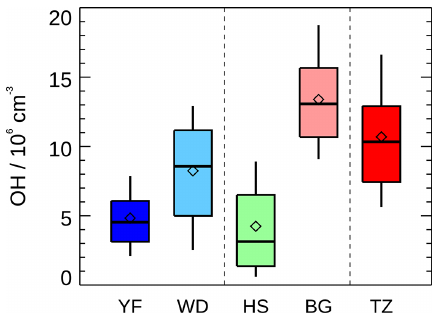
Figure 5. Summary of OH radical concentrations (noontime, 11:00–13:00) measured in five summer field campaigns in China. Yufa (YF) and Wangdu (WD) campaigns in the North China Plain, Heshan (HS) and Backgarden (BG) campaigns in the Pearl River Delta, and Taizhou (TZ, this study) campaign in Yangtze River Delta. The box–whisker plot shows the 90th, 75th, 50th, 25th, and 10th percentile values of noon OH radical concentrations in each campaign. The diamond shows the mean values of noon OH radical concentrations.